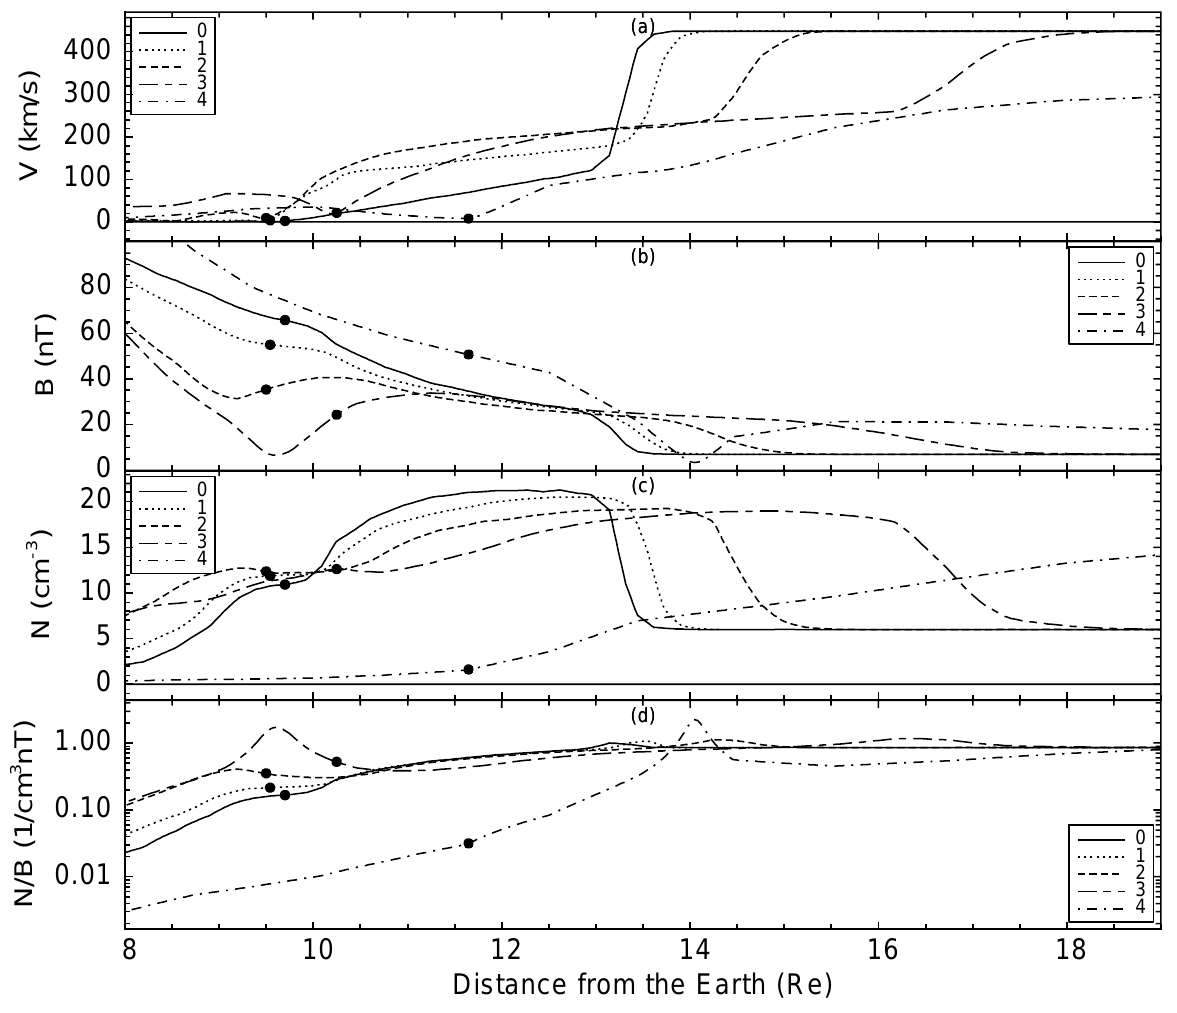
Fig. 5. Parameters along the radial straight lines in Fig. 3, plotted in the same format as in Fig. 4.